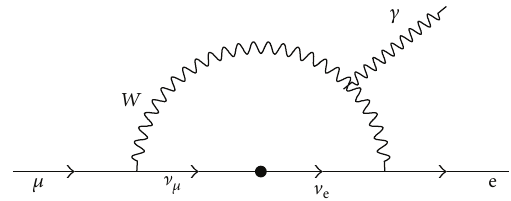
Figure 1: A loop diagram which induces the 𝜇 + → e + 𝛾 reaction in the SM. The closed blob corresponds to the flavour mixing of muon and electron